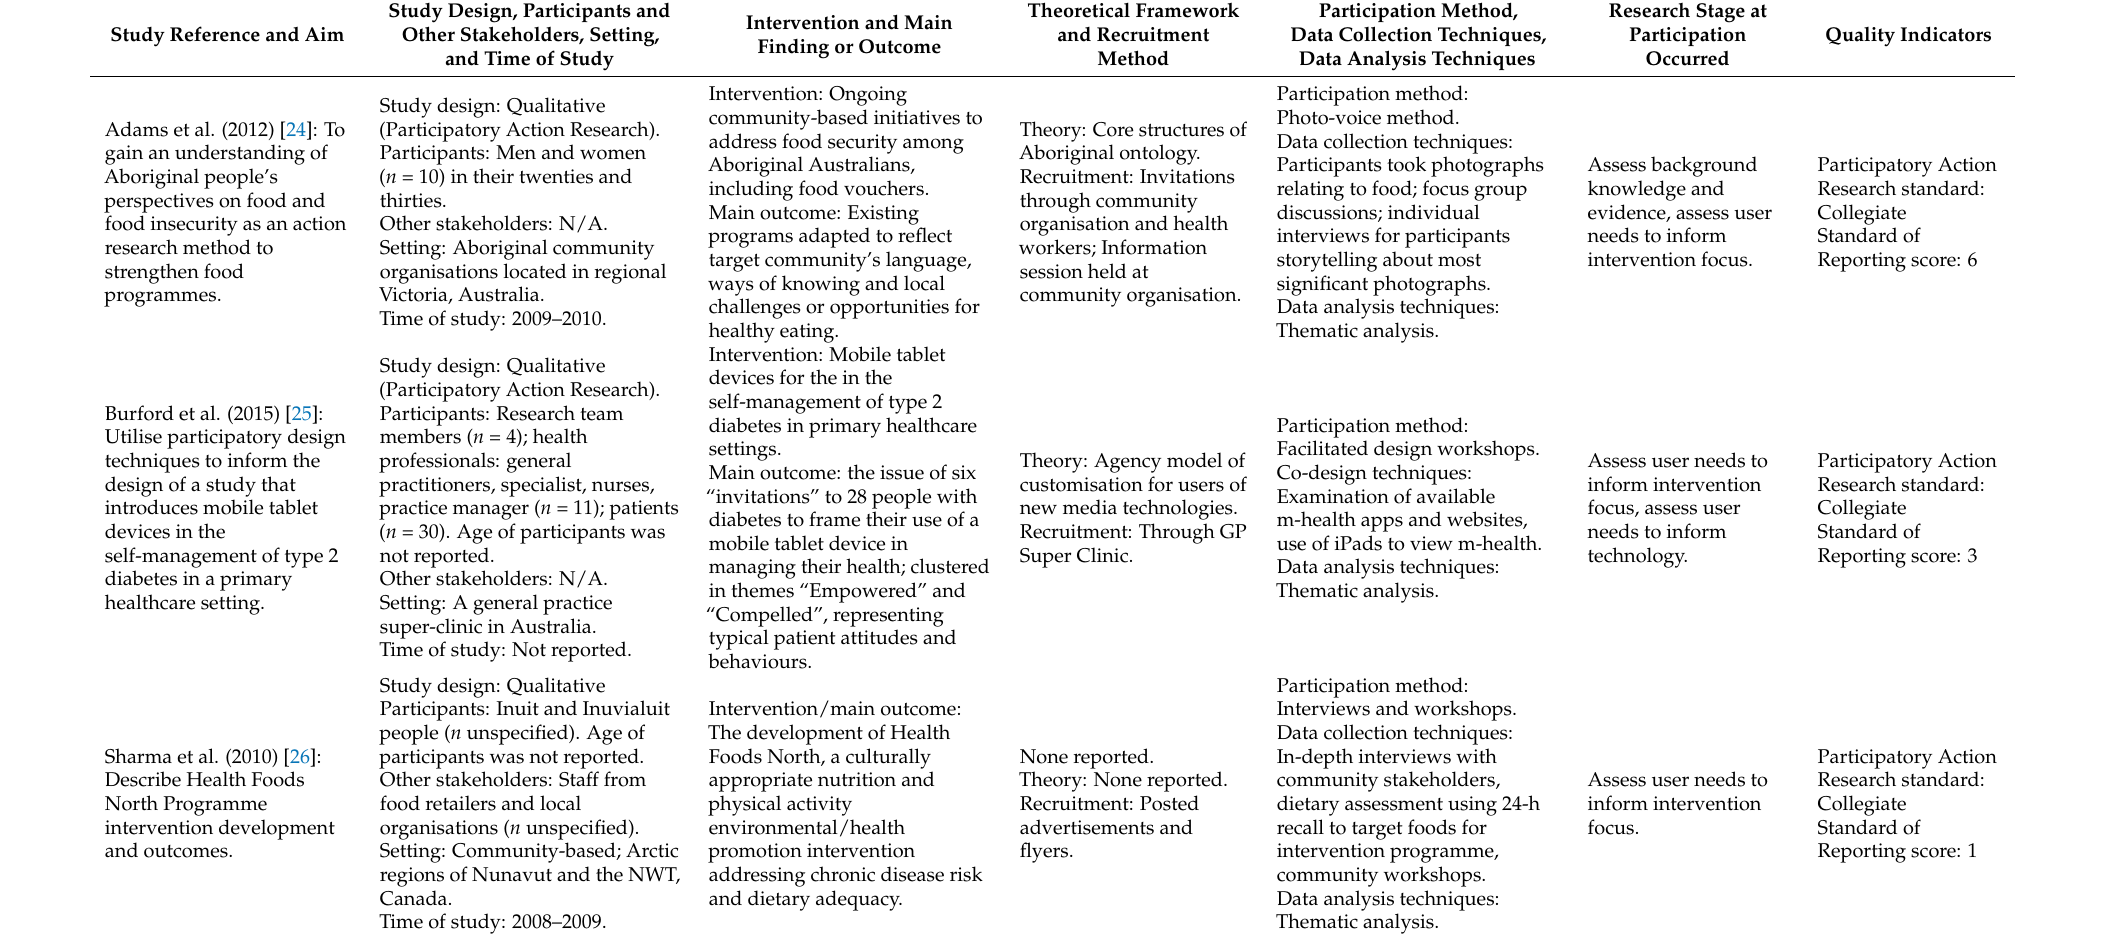
Table 3. Study characteristics, co-design methods used, and quality